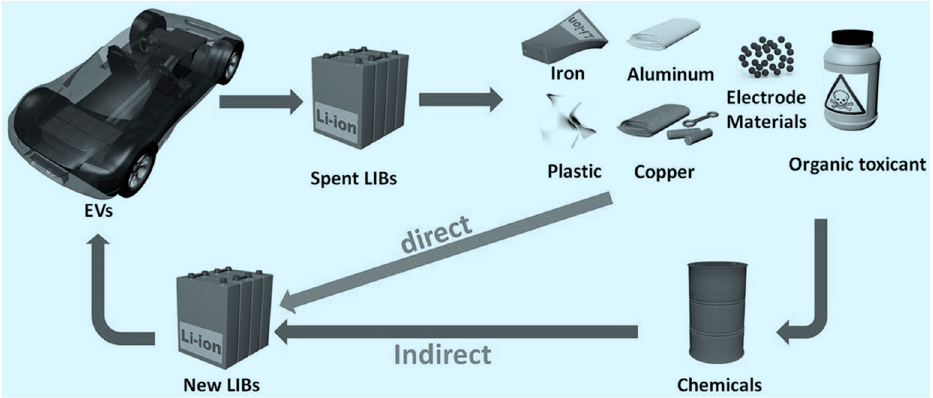
Figure 22. Perspectives for LIBs recycling.